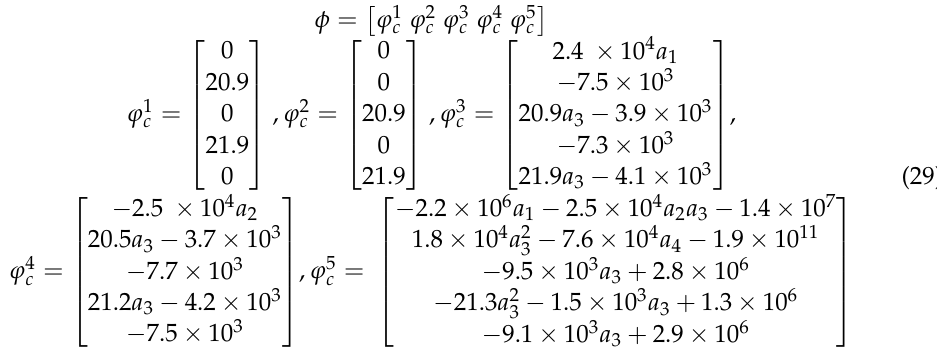
Figure 8. Control system operation (with and without type-2 fuzzy system) and without controller to ( a ) decrease and ( b ) increase DFIG parameters by 20%. As shown in Figure 8, the sudden decrease or increase of DFIG parameters (as much as 20%) was well-managed by the optimal control system (with and without the type-2 fuzzy system), and after about 0.03 s, the system returned to its stable mode. However, the system without a controller, in addition to many overshoots, suffered from a steady- state error. The reason that the system did not diverge (unstable) without a controller was that there were saturating elements and limiters in the system. The root mean square error (RMSE) and mean absolute error (MAE) are two popular statistical metrics used to evaluate the performance of models. They are defined as RMSE = (cid:3497)1 𝑛 (cid:3533)(𝑦 (cid:3038) − 𝑦 (cid:3038) (cid:3550)) (cid:2870)(cid:3041) (cid:3038)(cid:2880)(cid:2869)